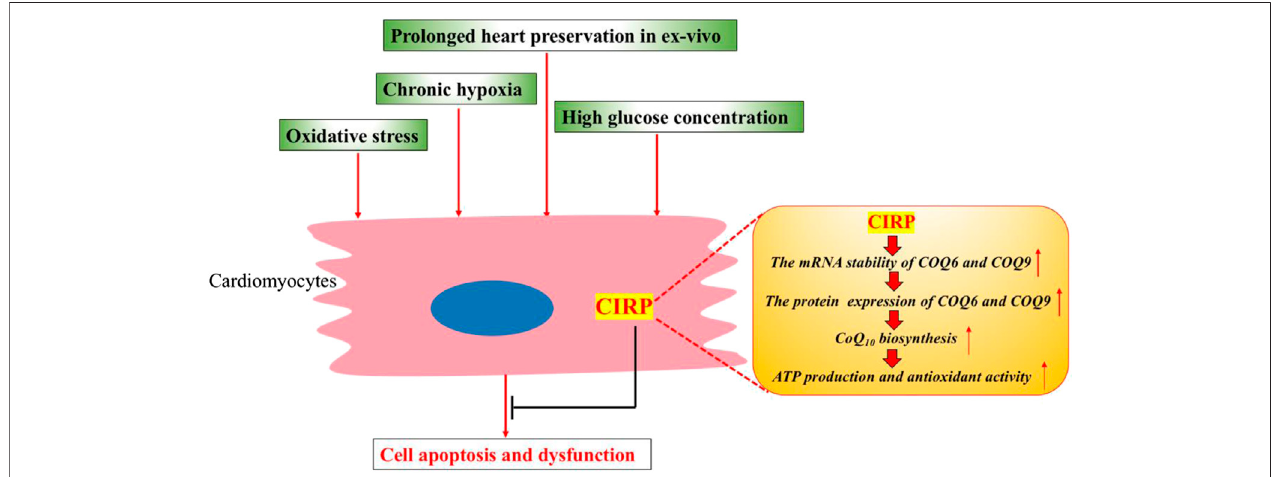
FIGURE 2 | CIRP protects cardiomyocytes from apoptosis and dysfunction under various stress conditions. CIRP can upregulate the CoQ10 biosynthesis by positively and posttranscriptionally regulating the protein expression of ubiquinone biosynthesis protein COQ9 and COQ6. CoQ10 could promote mitochondrial metabolism, leading to higher ATP production and improved antioxidant